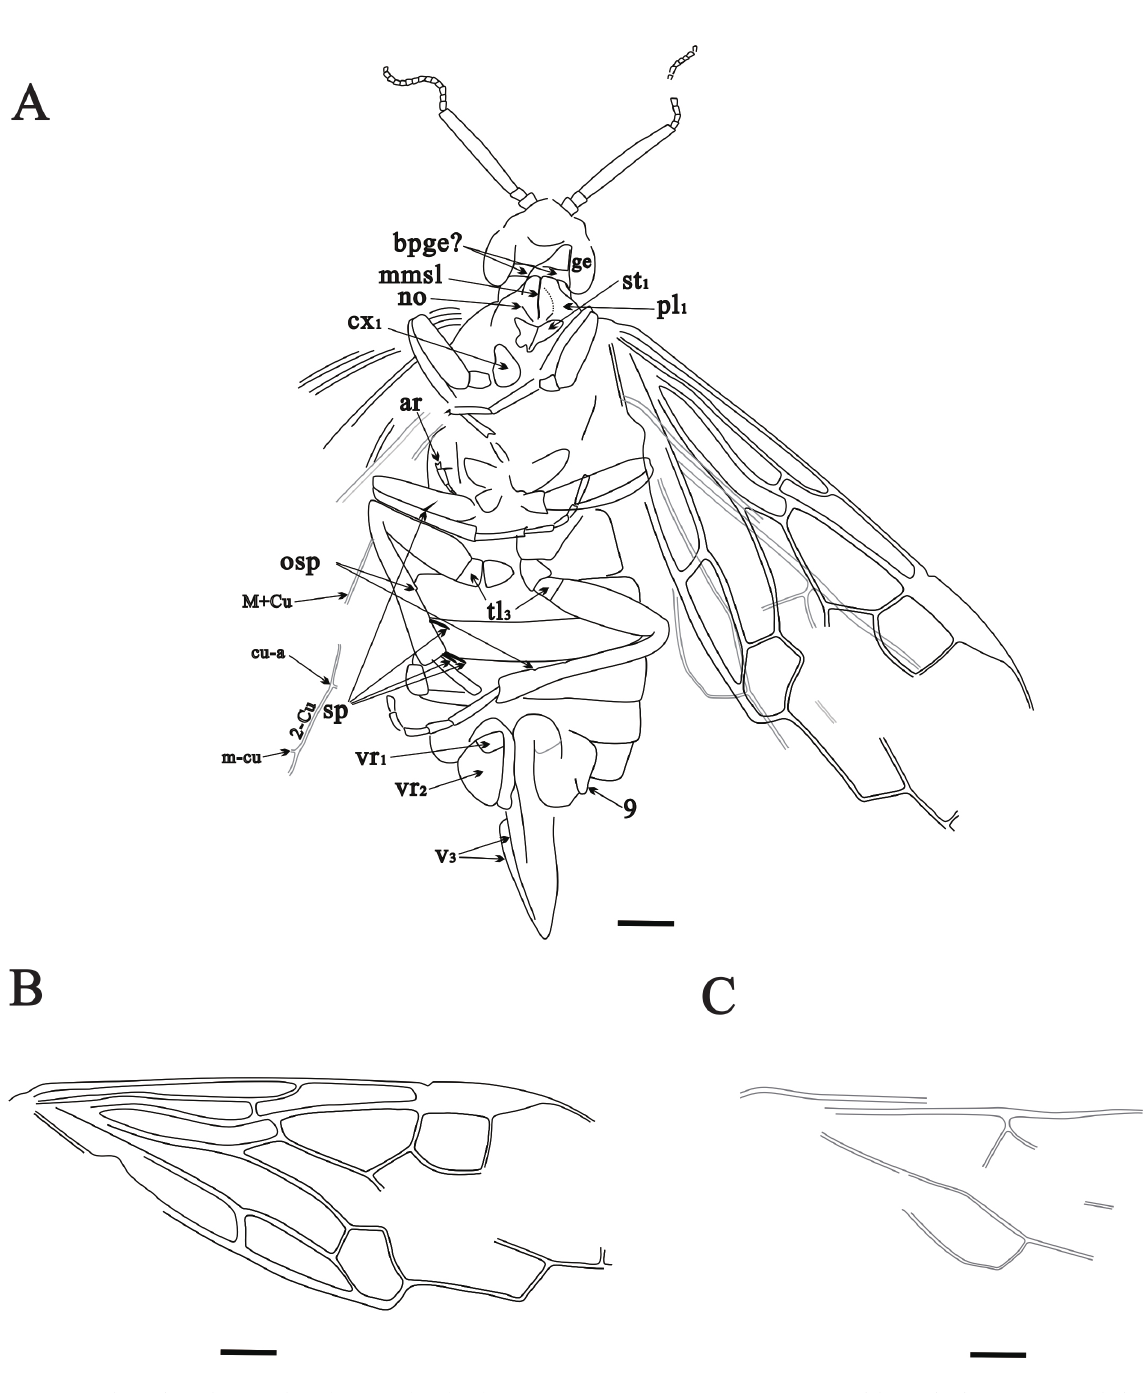
Fig. 5. Line drawings of Scleroxyela daohugouensis gen. et sp. nov. A . Habitus, holotype. B . Right forewing. C . Right hindwing. Symbols as in Fig. 3 except: ar = arolium; bpge? = possible postgenal bridge; ge = gena; mmsl = medial mesoscutal line; osp = attachment site of tibial spur; pl sp = tibial spur; st = prosternum; tl = hind trochantellus. Scale bars: 1 1 3